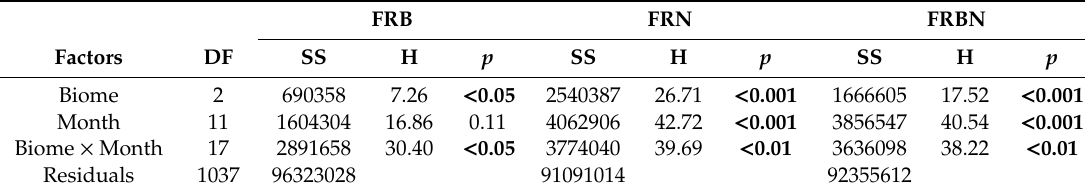
Table 1. E ff ects of biome, month and their interactions on monthly fine root biomass (FRB; n = 1068), necromass (FRN; n = 1068) and their biomass / necromass ratio (FRBN; n = 1068) using a two-way nonparametric Scheirer-Ray-Hare (SRH) test. H-values of SRH test are given.